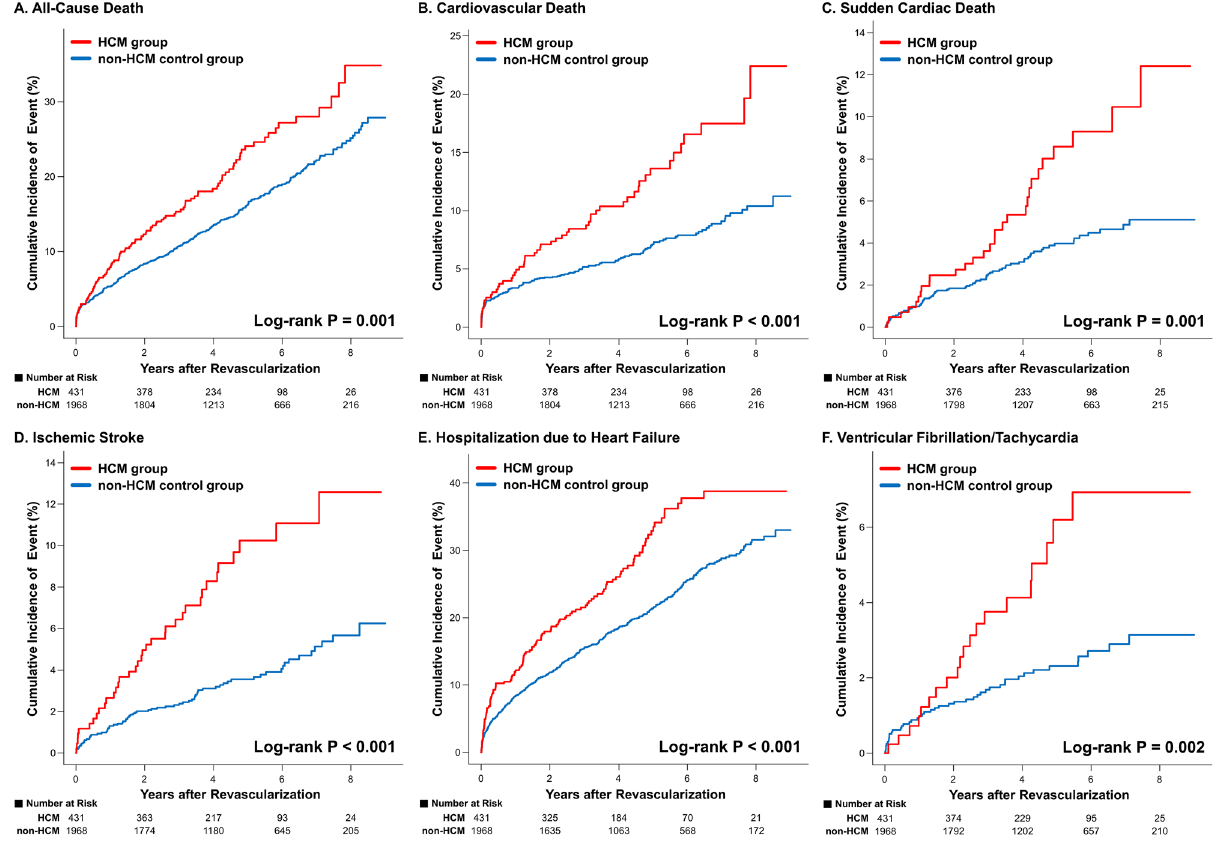
Figure 2. Cumulative incidence and risk of cardiovascular outcomes in HCM versus non-HCM Control Group. Kaplan–Meier curves of ( A ) All-cause death, ( B ) Cardiovascular death, ( C ) Sudden cardiac death, ( D ) Ischemic